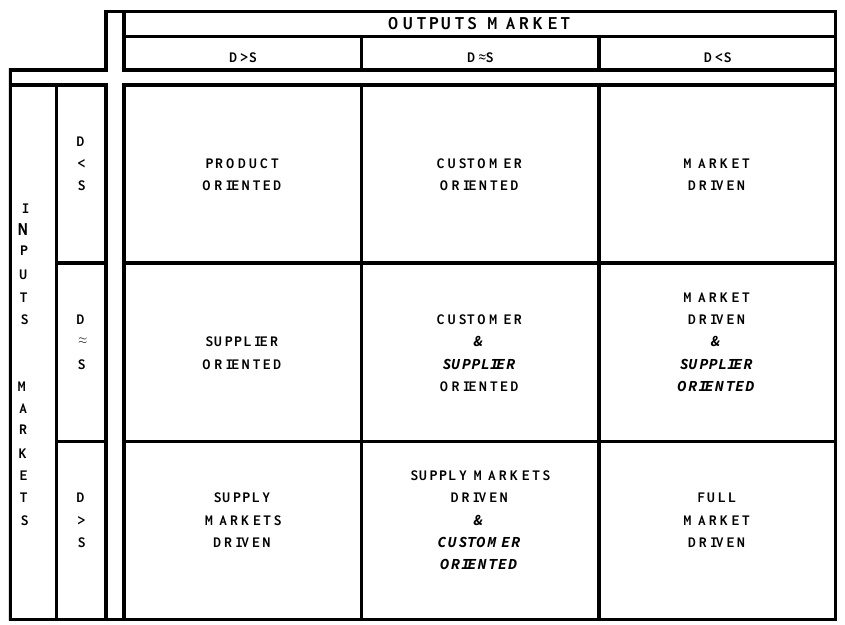
Figure 1: Market-Driven Intensity